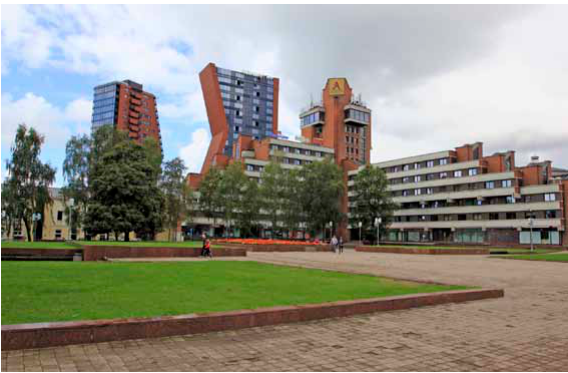
fig. 11. The new sign of Klaipėda’s urban identity is the “KD” building complex. although it has a significant visual impact on the existing central part of the city, yet the latter’s image is not positively enhanced by such composition of